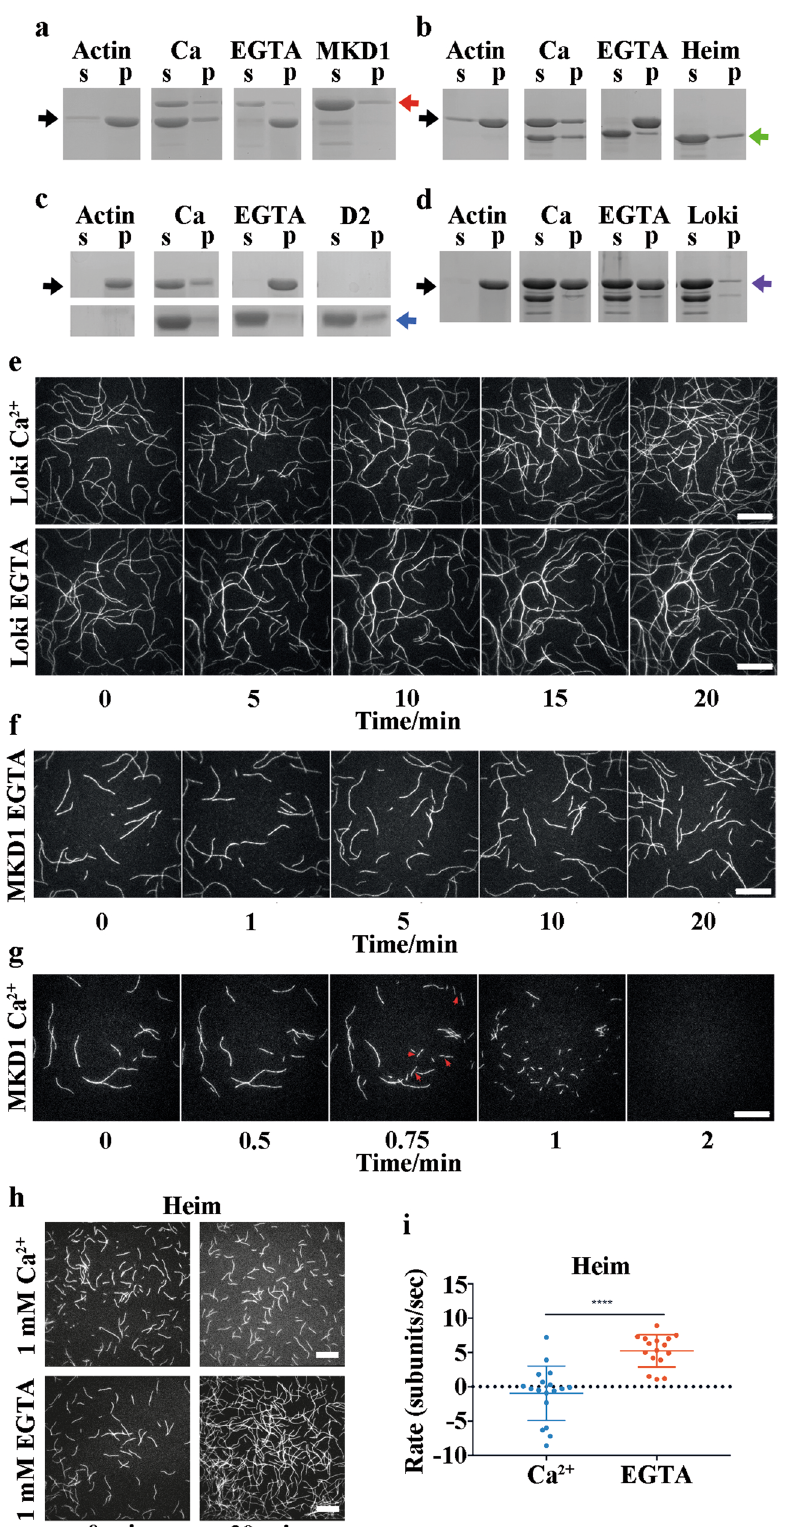
Heim2DGel Tail. Transfection of this construct resulted in a uniform GFP signal throughout the cell, including the nucleus (Fig. 6b). The loss of cellular actin fi laments, on treatment with ionomycin, was comparable for the full length and truncated Heim2DGels (Fig. 6a and Supplementary Fig. 7), indicating that removal of the Heim Tail did not substantially effect its ability